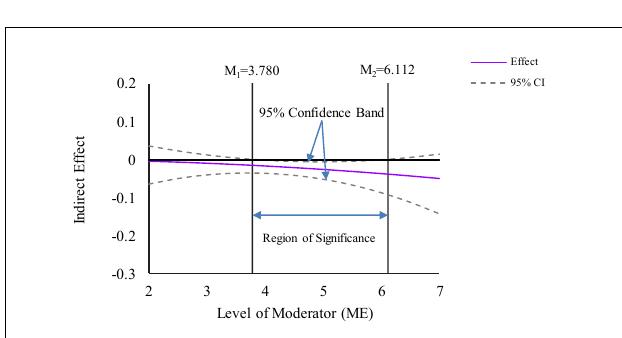
FIGURE 6 | Moderated mediation effect of ME (mediator = EGVs).